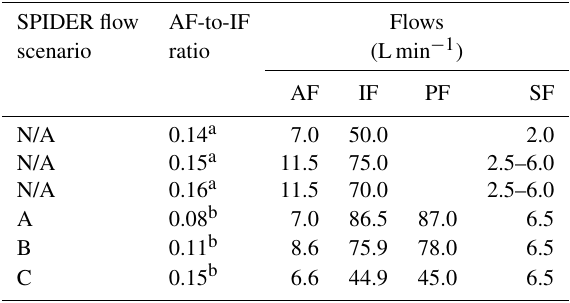
Figure 2. Schematic of SPIDER with its components labeled. (a) The L-PCVI (Hiranuma et al., 2016) separates interstitial aerosol from the droplets and ice crystals. (b) Thermocouples report the temperature in the chamber. (c) The chamber is cooled and held at ice saturation to evaporate droplets. (d) The PCVI downstream sep- arates evaporated droplet residuals from ice crystals. (e) The bottom houses electronics and mass flow controllers (MFCs). Table 1. L-PCVI flow